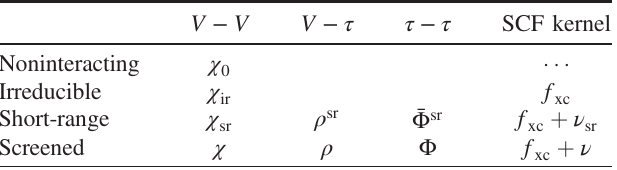
TABLE I. Summary of the main response functions that we consider in this work, together with the SCF kernel that governs the electron-electron interactions in each case. The three central columns refer to the charge response to a scalar potential ( χ ), the charge response to a phonon ( ρ ), or the atomic forces induced by a phonon ( Φ ). [They can all be expressed as second derivatives of the energy with respect to scalar potential ( V ) and/or phonon ( τ ) perturbations.] f is the exchange and correlation kernel; ν is the xc Coulomb kernel; for the meaning of the short-range (sr) label, see the